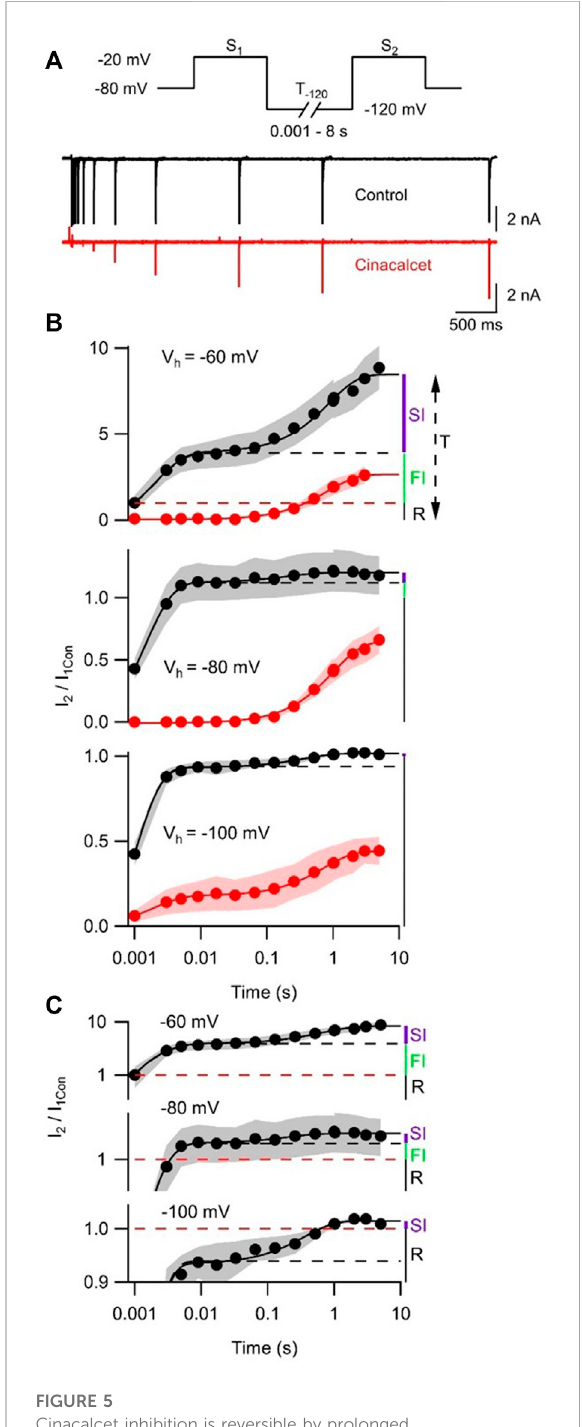
inhibition was relatively slow [Figure 5B and (Mattheisen et al., 2018)], the rate of inhibition of VGSCs (dB/dt) by the FIGURE 5 Cinacalcet inhibition is reversible by prolonged hyperpolarization. (A) Superimposed representative traces from a double pulse protocol (S1 and S2) used to elicit VGSC currents in control (top, black) or after complete inhibition by 5 µM cinacalcet (bottom, red) in the whole cell from a holding potential (V h ) of − 80 mV. Test pulses S1 and S2 are 10 ms in length and separated by a variable-length recovery period at − 120 mV. (B) Graph showing double-exponential increase in VGSC current molecule, and k represents the association constants for the three ( Continued VGSC states. By incorporating a constant, C: